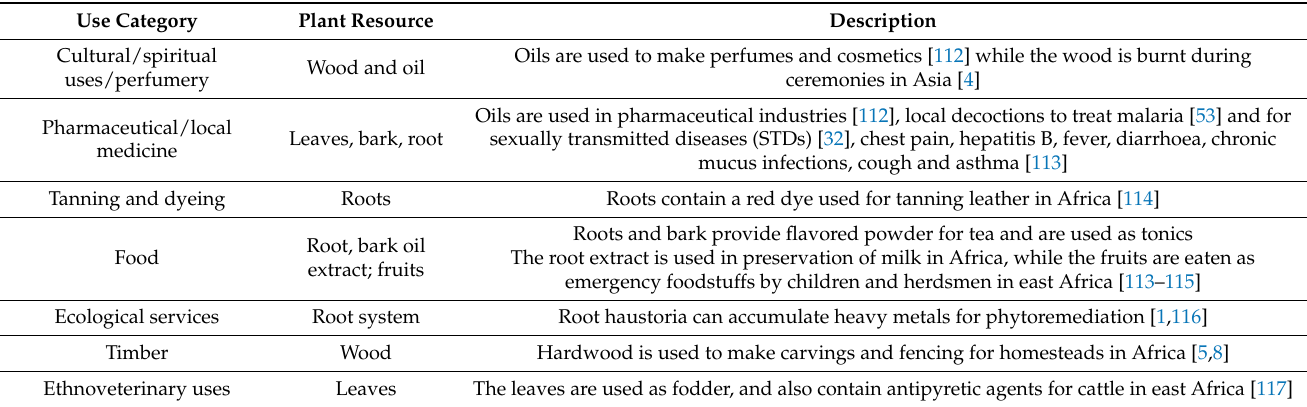
Table 3. Ethnobotanical uses of Osyris lanceolata